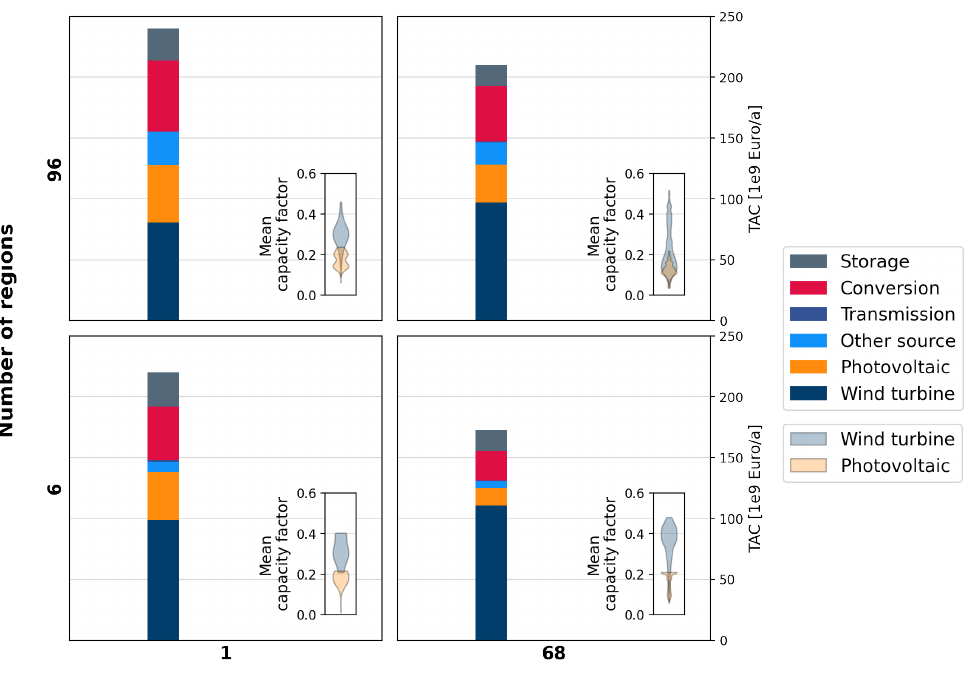
Figure 8. The results of optimization for the extreme parameter combinations (i.e., 6 and 96 regions and 1 and 68 VRES time series per region). For each of these combinations, TAC for different technologies is seen on the left, and the distribution of installed VRES capacities on the